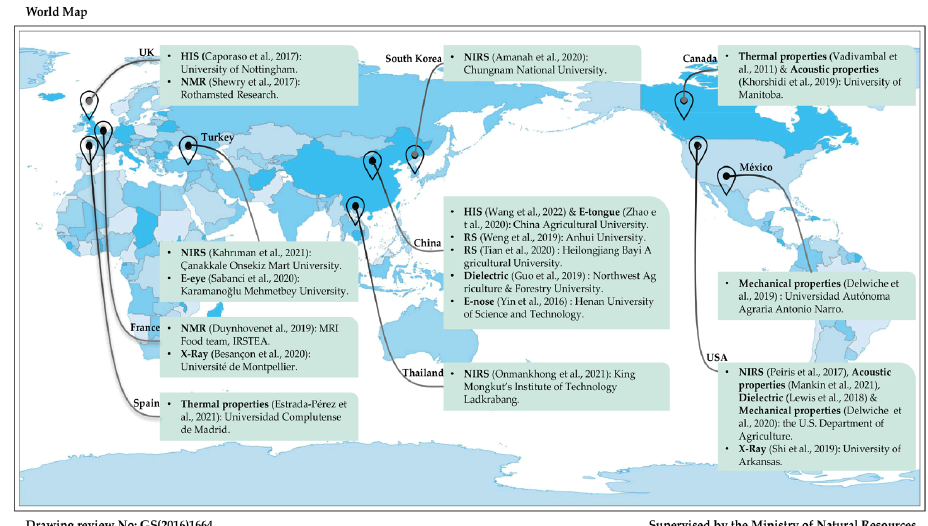
Figure 1. The research progress of research institutions on grain quality detection techniques [30–52].